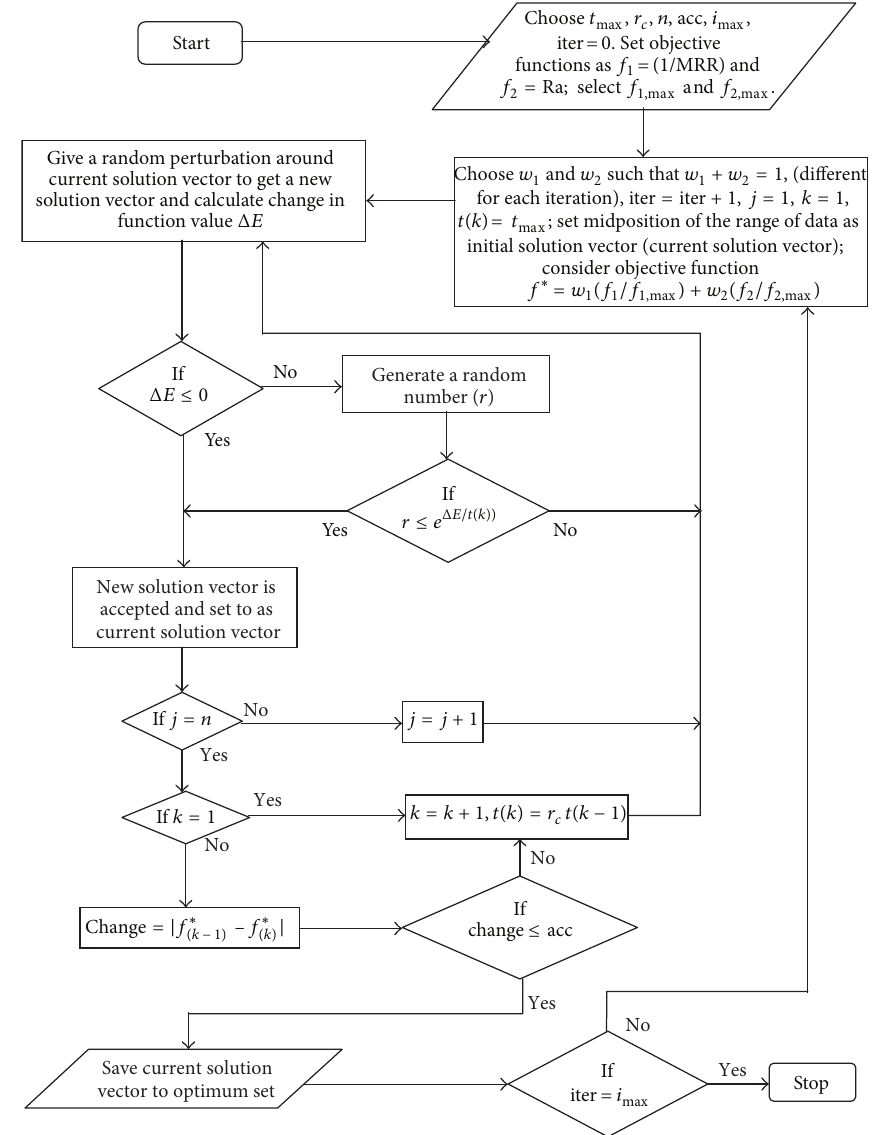
Figure 8: Flow chart for weight-varying multiobjective simulated annealing.